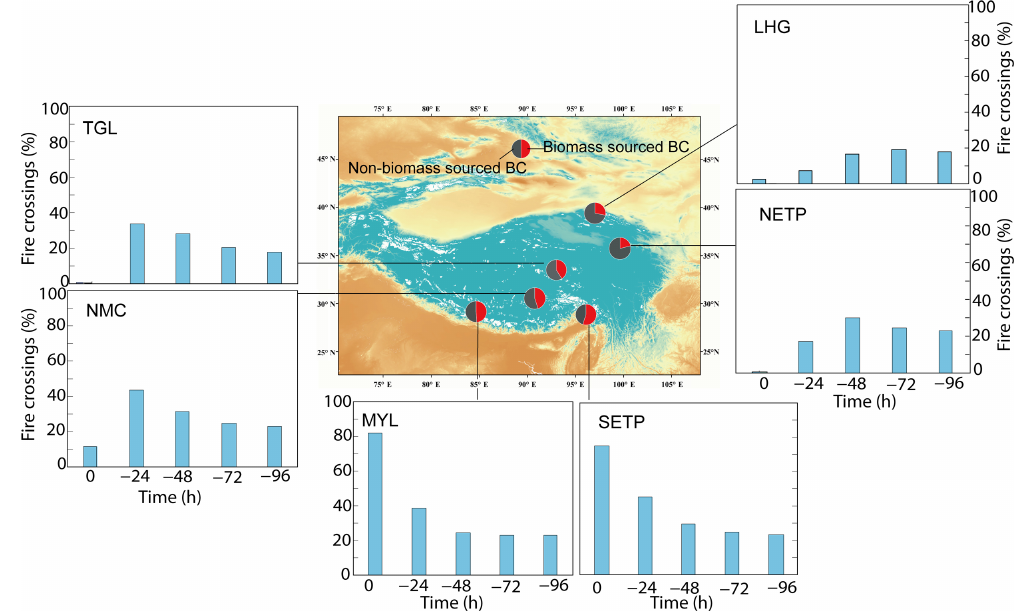
Figure 5. Different source contributions to BC deposition on the snow cover across the Tibetan Plateau. Table 5. Average reductions of snow cover duration by BC and dust for different short wavelengths (220, 270, and 310Wm − 2 , respectively) and snow cover depth water equivalent (mmw.e.). SD SD = 40mmw.e. SD = 100mmw.e.